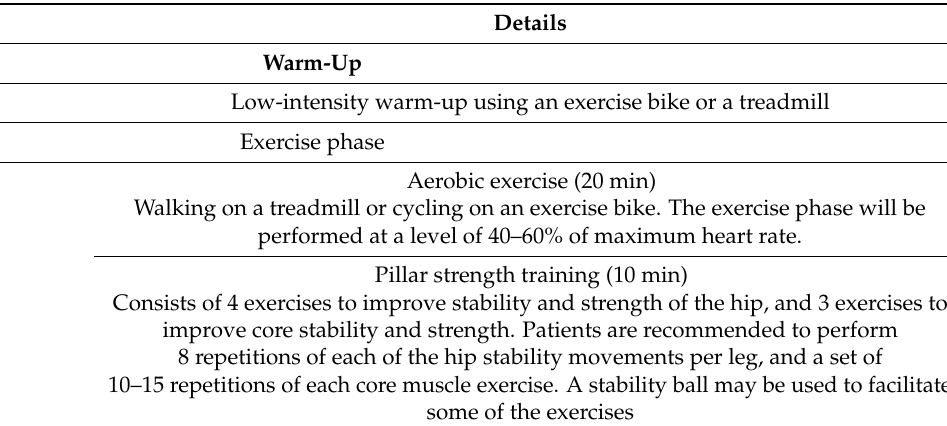
Table 1. The EPEC-FAST Exercise